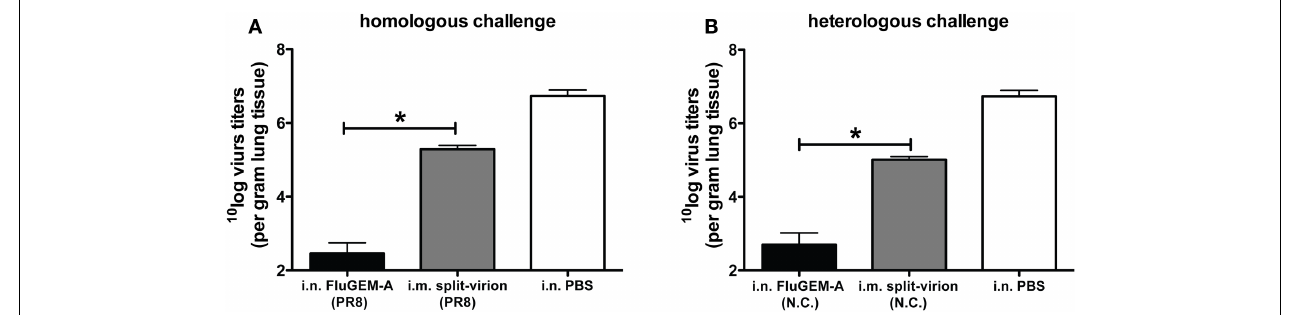
PR8 virus. Lung virus titers were determined 5days post-challenge.Virus titers measured after homologous challenge in the lungs of mice vaccinated i.n. with PR8-derived FluGEM-A vaccine were up to 100-fold lower compared to titers measured in lungs of mice vaccinated i.m. with PR8-derived split-virion vaccine (A) .Virus titers measured after heterologous challenge in the lungs of mice vaccinated i.m. with New Caledonia-derived split-virion vaccine were significantly higher than titers measured in the lungs of mice vaccinated i.n. with New Caledonia-derived FluGEM-A vaccine (B). * p < 0.05; one-tailed Mann–Whitney U test ( n =